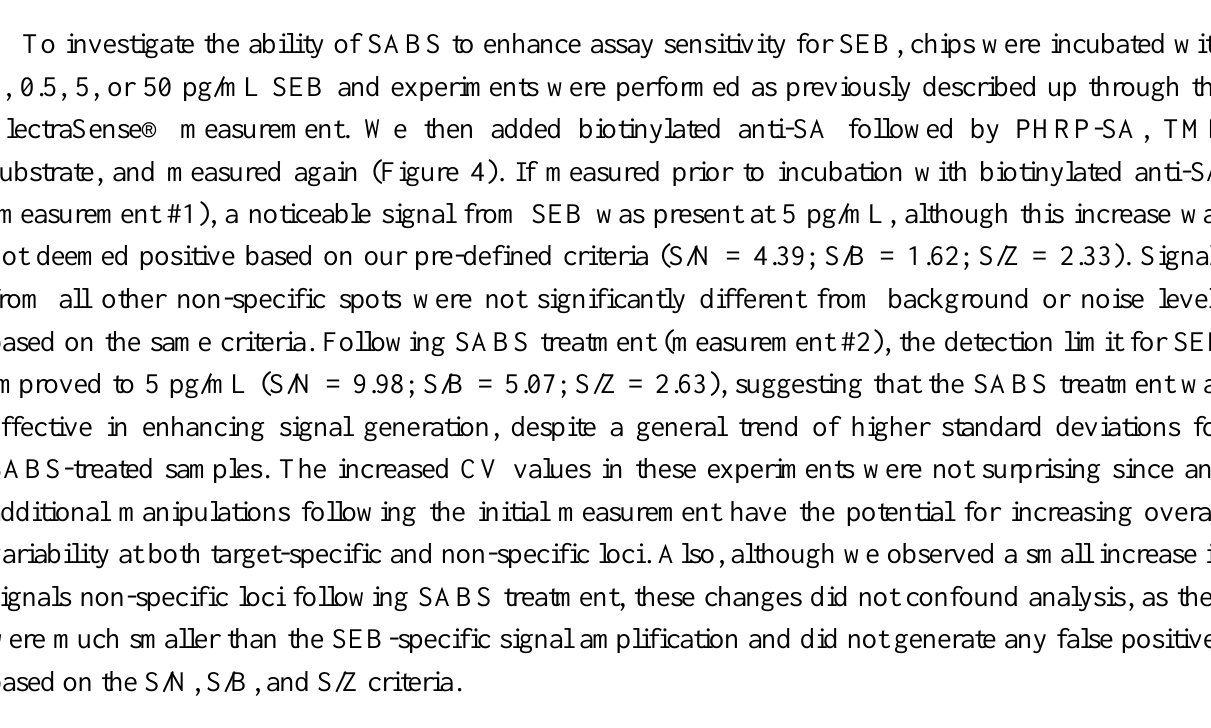
Figure 4. SABS assay for SEB. Chips were incubated with 0 pg/mL, 0.5 pg/mL, and 5 pg/mL. Anti- B. anthracis , anti- Y. pestis , and anti-SEB refer to the antibodies immobilized on the chip surface. Mean signals and SD are